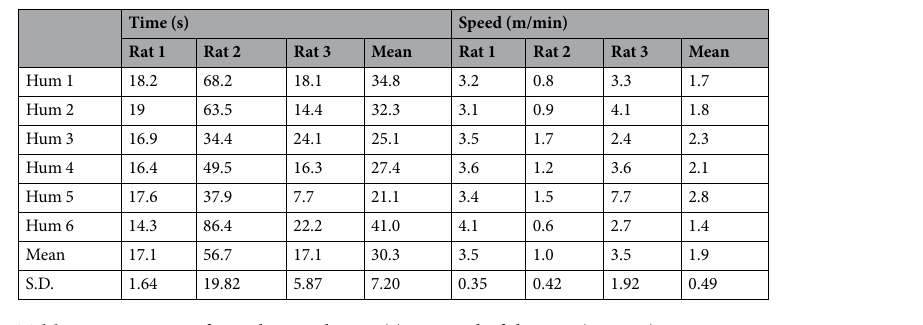
Table 2. Mean time for task completion (s) & speed of the rats